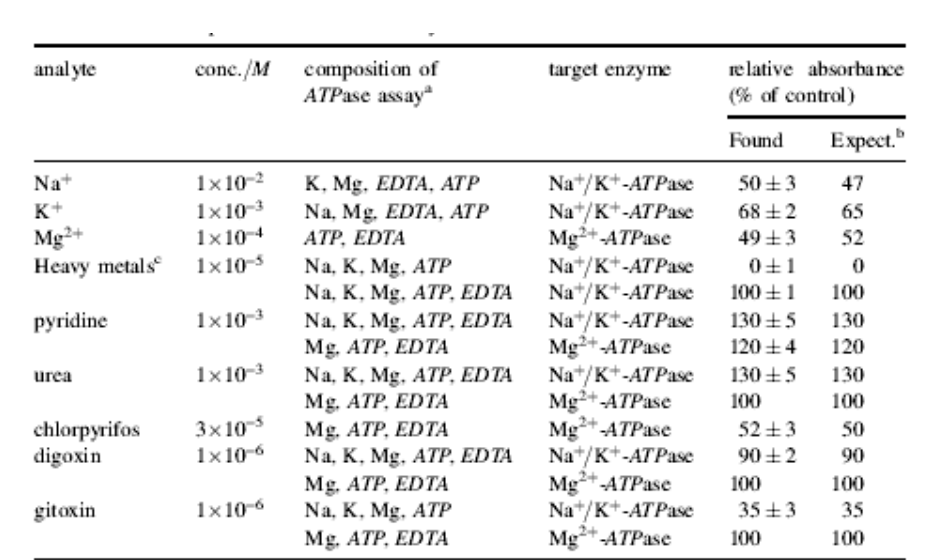
Table 3. Spectrophotometric response of the colorimetric assay in the presence of single analytes as the function of composition of ATPases assay. Reproduced from